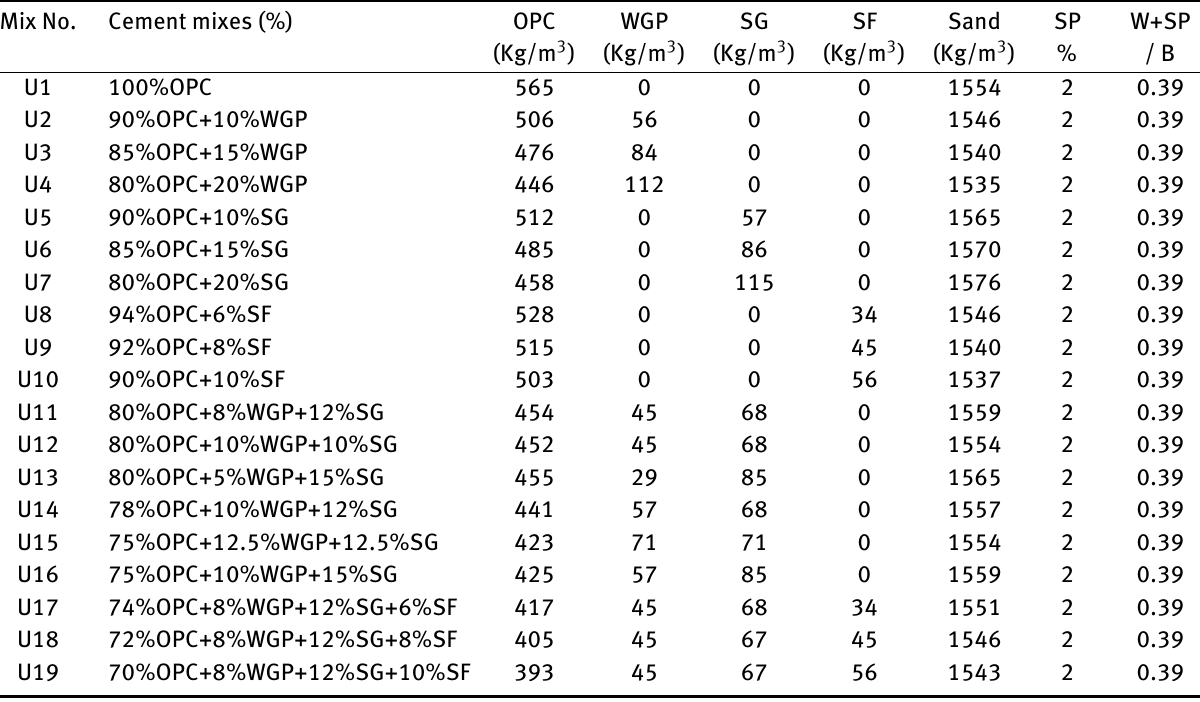
Table 5: Mix proportions of non-reinforced green mortar.